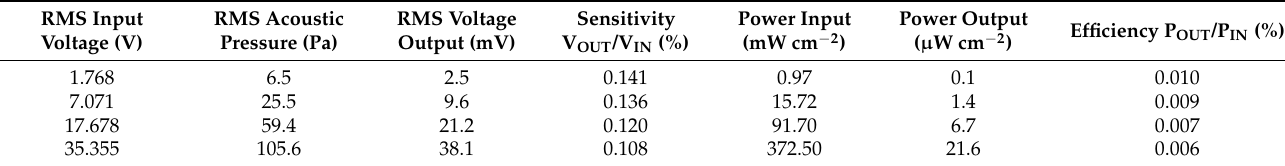
Table 3. Experimentally obtained results for the UPD